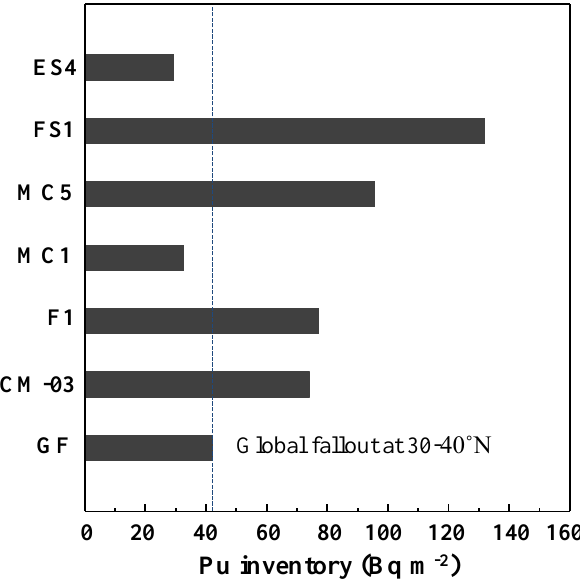
Fig. 5. Pu inventories in the sediment cores. The Pu inventory of CM-03 (0–10cm) was cited from Zheng and Yamada (2006b). The global fallout Pu inventory at 30–40 ◦ N was from UN- SCEAR